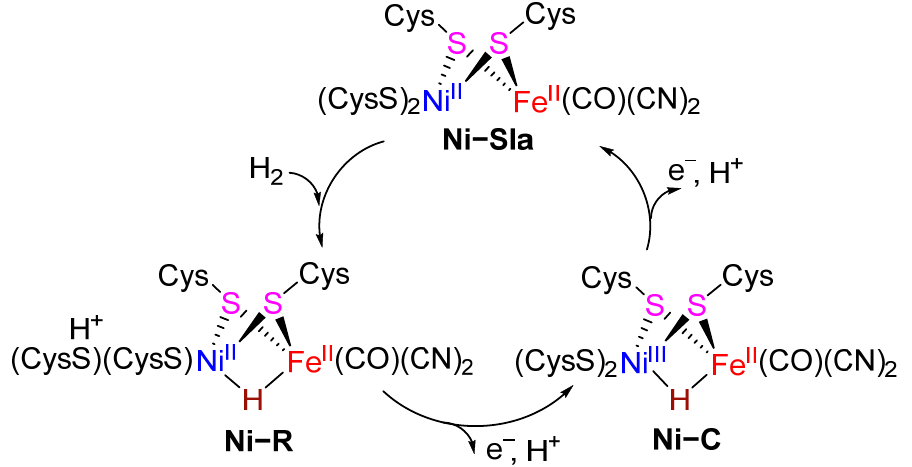
Figure 1. Some states of [NiFe]-H 2 ases associated with a suggested catalytic cycle for H 2 activation. The well-elucidated active site structure and the identified states of the active site during H 2 activation catalyzed by [NiFe]-H 2 ases have promoted researchers to synthesize a wide variety of [NiFe]-H 2 ase models [22–45]. In recent years, we have prepared some [NiFe]-H 2 ase model complexes and some of them were proved to be functional models of [NiFe]-H 2 ases [35,37,38,42–45]. To develop the biomimetic chemistry of [NiFe]-H 2 ases and to understand the reversible H 2 activation catalyzed by [NiFe]-H 2 ases, we further